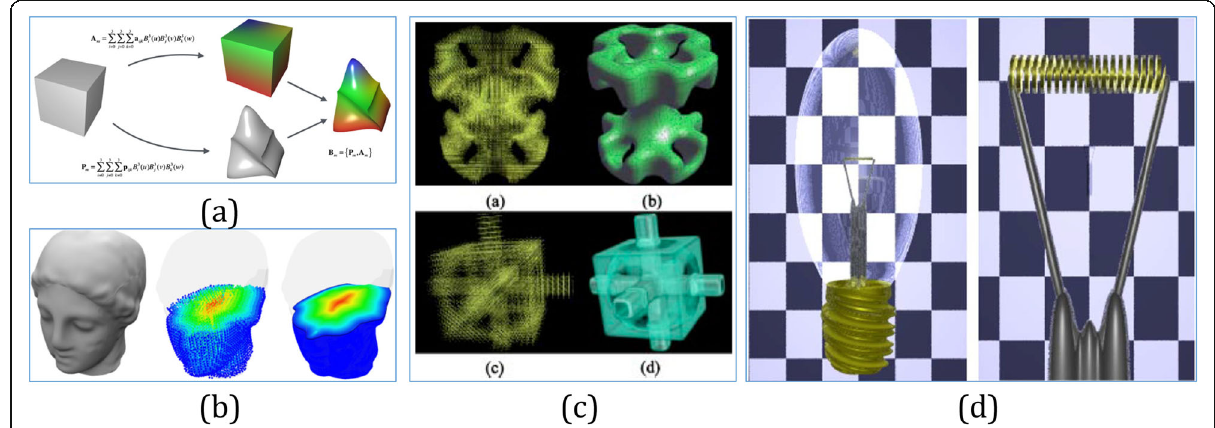
Fig. 7 a A comprehensive framework for modeling heterogeneous objects [56]. b Volumetric attribute data represented by trivariate B-spline functions [64]. c Trivariate Simplex Splines for inhomogeneous solid modeling [65, 66]. d Complex heterogeneous object modeled using trivariate B- spline primitives